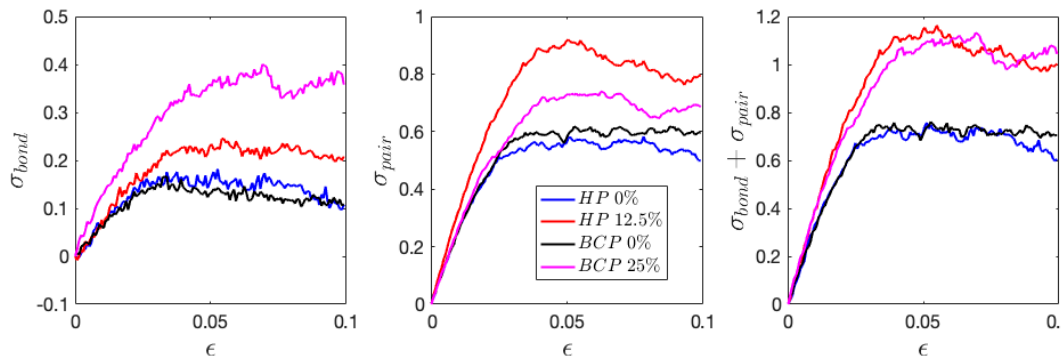
Figure 14. The change of bonded and pair (Van der Waals + coulombic) stress contribution relative to the initial values at zero deformation during tensile loading perpendicular to the